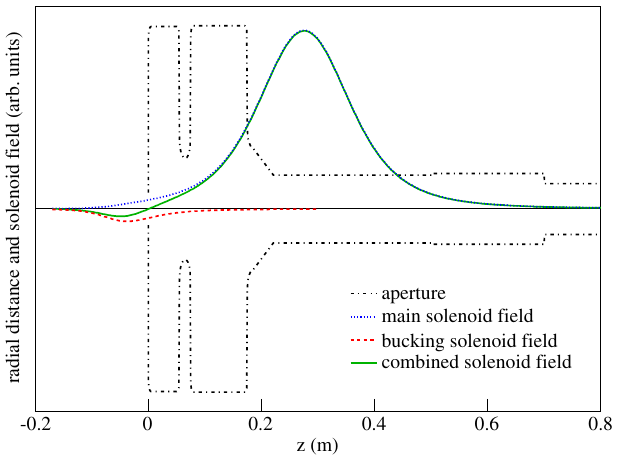
FIG. 6. (Color) A typical trace of dark current from the PITZ gun cavity as a function of time during one rf pulse (full red line). The dark current was measured with the Faraday cup 0.78 m downstream of the cathode. The rf forward power (dotted blue line) is also shown to indicate the rf pulse